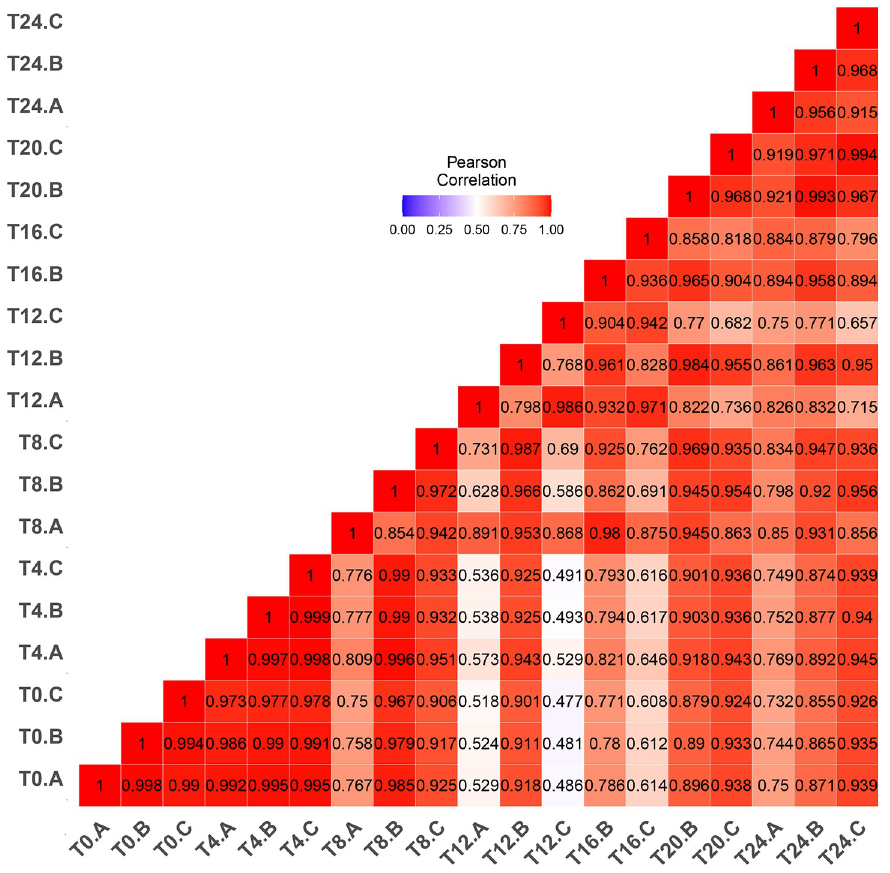
Fig 1. Correlation of global transcription among biological replicates (A-C) for ~6,900 E . acervulina genes as oocysts sporulate. Transcripts Per Million (TPM) were compared for each biological replicate every four hours during sporulation. Individual squares represent Pearson Product correlations among replicates at each time point. Correlations were greatest initially (hours 0–4 [T0-T4]) and after sporulation’s completion (hours 20–24: [T20-T24]). https://doi.org/10.1371/journal.pone.0258157.g001 Maximum expression for any gene ranged from 30,654 (T20) to 52,966 (T4) (accounting for 3.1–5.3% of total transcripts, Table 2). To narrow our search for important and easily amplified biomarkers, we thereafter established 1,000 TPM (0.1% of the total) as a cutoff for Table 2. RNA-Seq expression analytics for E . acervulina oocysts during